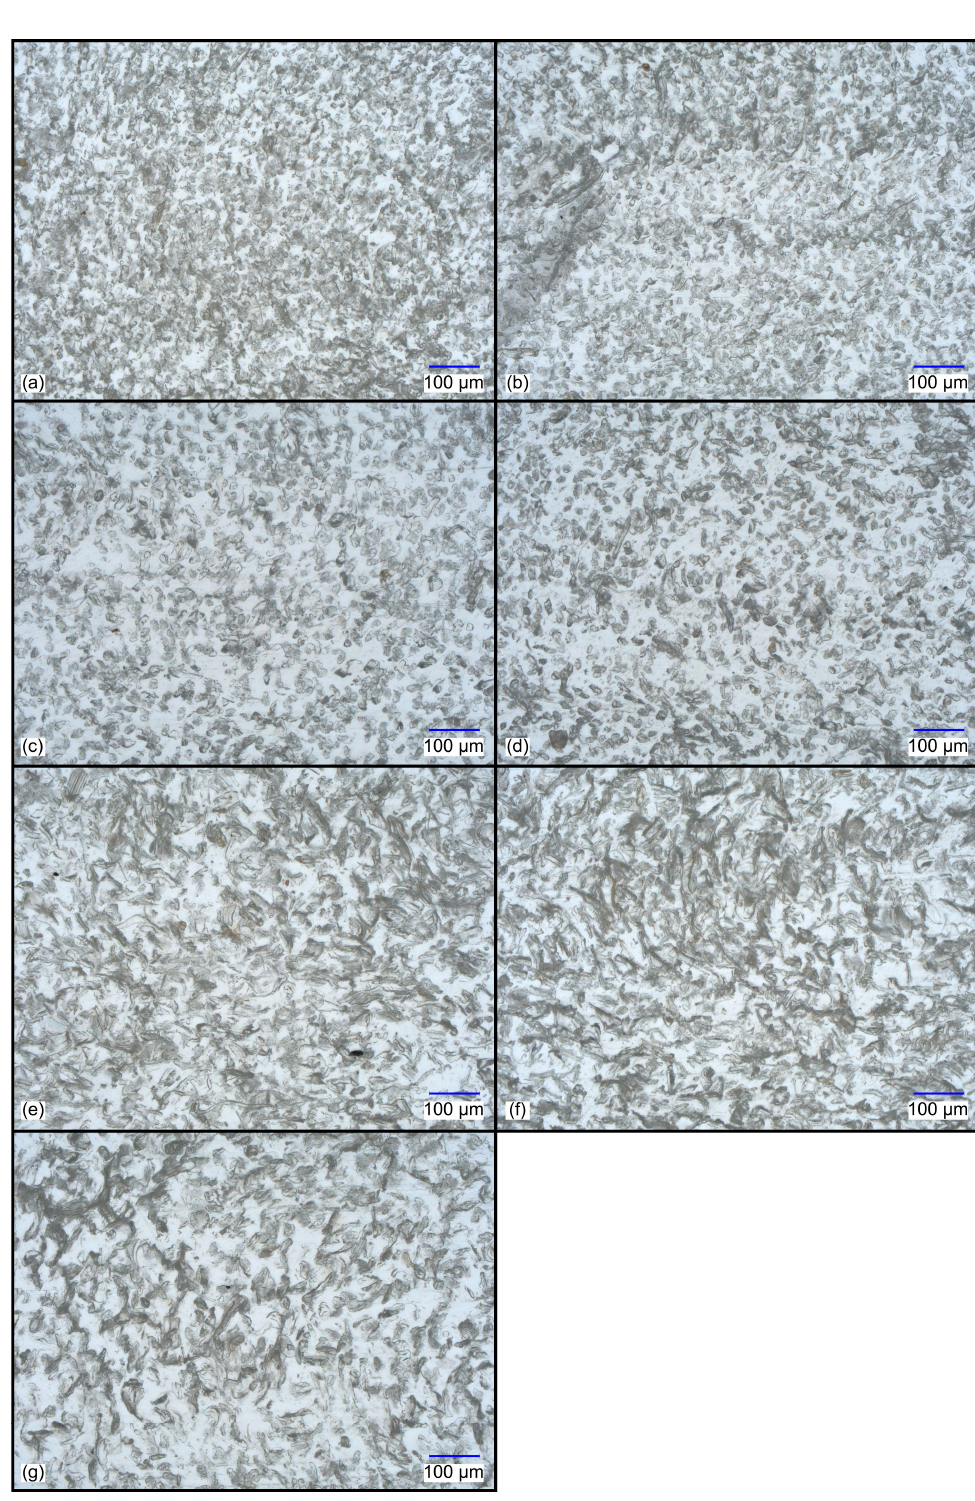
Figure 1. Optical micrographs of tensile test specimens’ cross ‐ sections of samples: ( a ) D_0.5 ‐ 3; ( b ) D_0.9 ‐ 5; ( c ) D_1.7 ‐ 5; ( d ) D_1.7 ‐ 10; ( e ) V_2.4 ‐ 5; ( f ) L_2.5 ‐ 5; ( g ) G_3.3 ‐ 5.